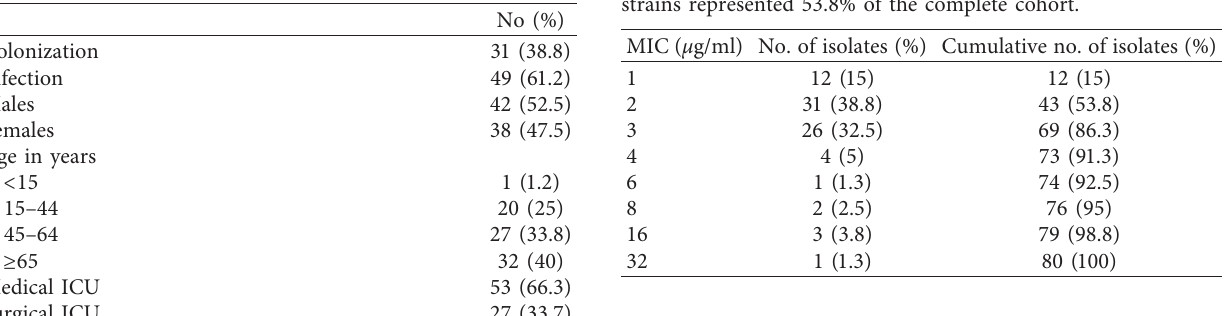
Table 1: Characteristics of critically ill patients from whom the carbapenem-resistant A. baumannii was isolated. The frequency of isolation showed an increasing trend with age.